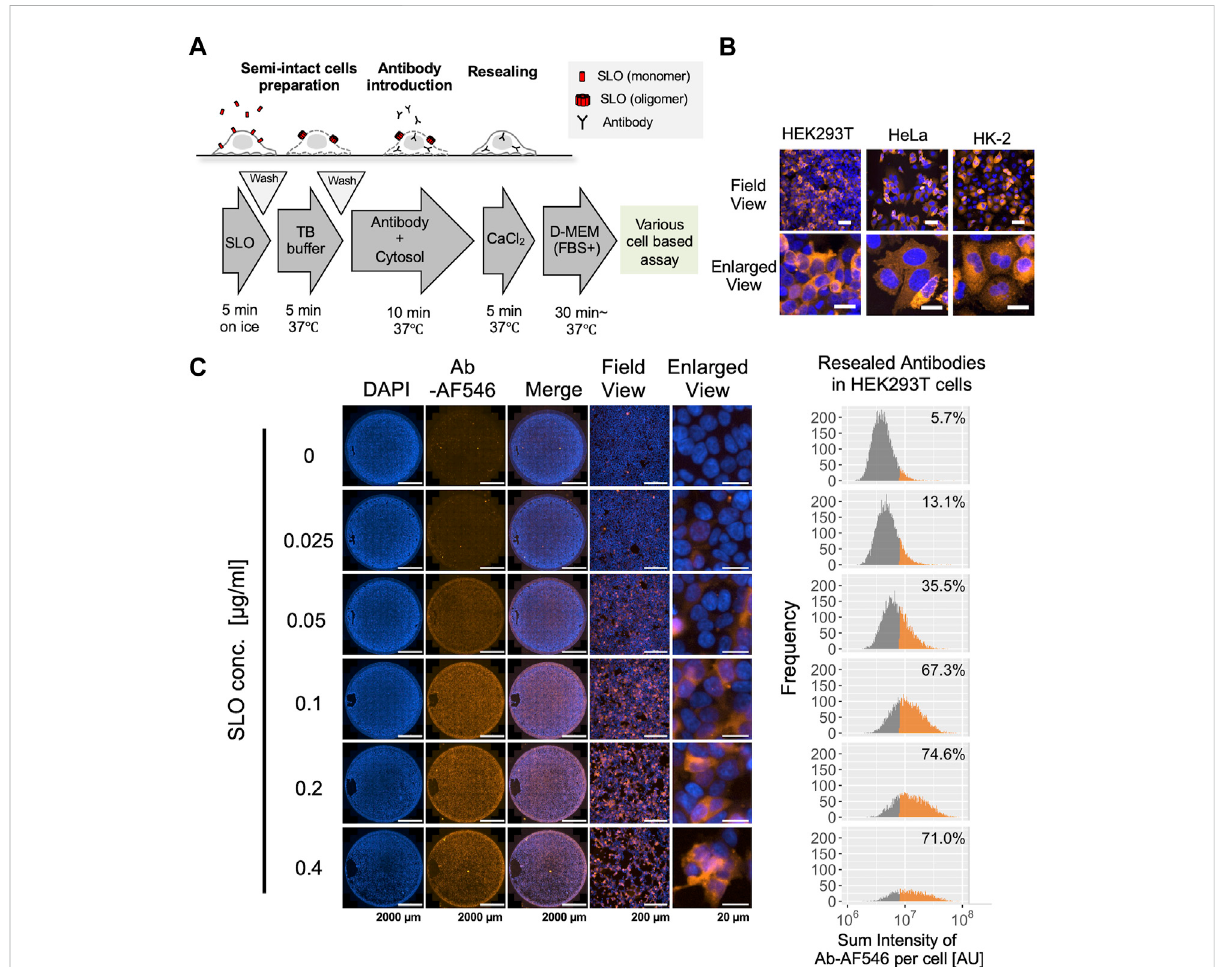
FIGURE 1 Cytosolic delivery of antibodies using the cell resealing technique. (A) Outline of the streptolysin O (SLO)-mediated cell resealing technique. Cells were treated with ~0.4 μ g/ml of SLO on ice for 5 min and incubated with prewarmed transport buffer (TB) at 37 ° C for 5 min, and the permeabilizedcellswereincubatedwiththeantibodyandexogenouscytosolsupplementedwithanATP-regeneratingsystem,GTP,andglucosefor 10 min. Cells were then resealed by incubation with 1 mM CaCl 2 for 5 min at 37 ° C and allowed to recover in the incubator at 37 ° C. (B) Confocal microscopy image of antibody-resealed HEK293T, HeLa, and HK-2 cells, fi xed 3 h after resealing and stained with secondary antibody. Antibodies were successfully introduced without excessive cell damage. Scale bars: 50 μ m (top panel); 20 μ m (bottom panel). (C) Evaluation of optimal SLO concentrationinHEK293T cells. Cellswerepermeabilized with0.025,0.05, 0.1,0.2, or0.4 μ g/mlofSLO,and AlexaFluor546-labeled non-targeting antibody(Ab-AF546)wasresealedaccordingtotheprotocoloutlinedinA.Cellswere fi xed1 hlaterandimagedusingCytation5.Whole-wellimages show that the labeled antibodies were introduced throughout the well from the center to the periphery. Histograms (right) show the sum fl uorescence intensities of the antibodies measured per cell and the percentage of fl uorescently labeled antibody-positive cells. Low and high SLO concentrations resulted in inef fi cient permeabilization and excessive cell damage, respectively, leading to a decrease in live cells. The optimal SLO concentration was 0.1 μ g/ml for HEK293T cells. Ab: antibody, AU: arbitrary unit. Scale bar: 2,000 μ m (Well view); 200 μ m (Field view); 20 μ m (Enlarged